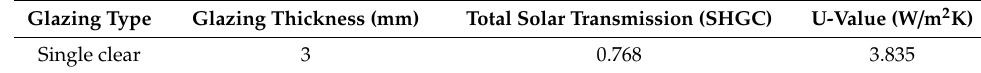
Table 3. Glazing specifications.